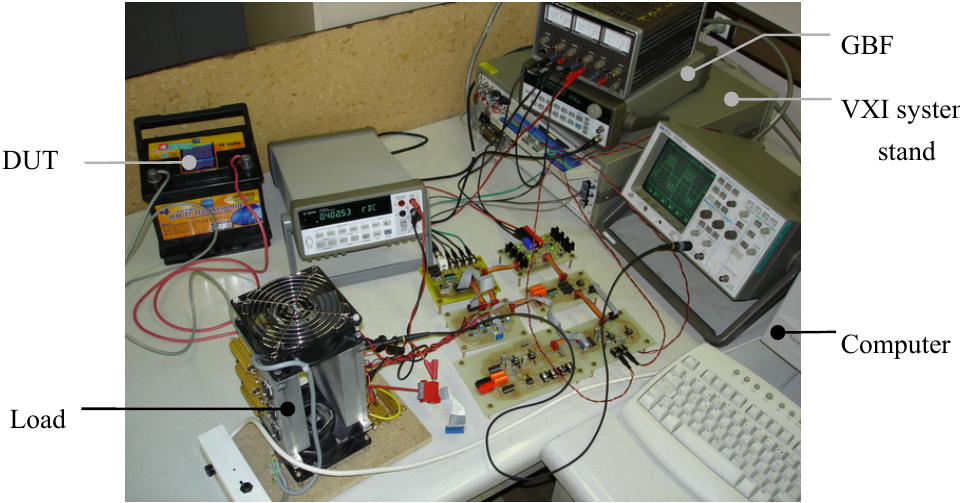
Figure 6. Test bed for the impedance measurement of a fuel cell on